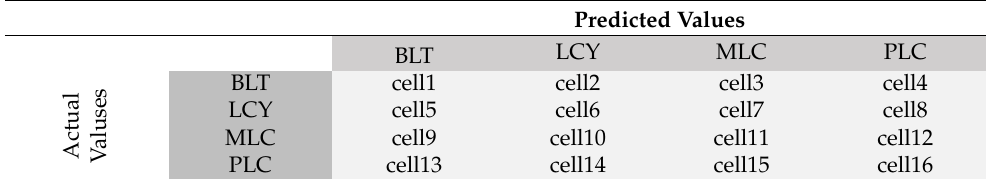
Table 1. Confusion matrix for multiclass classification. Actual values are the correct values of the ultrasound images of the test set. Prediction values are the predictions of the ultrasound images of the test set by the classifier. BLT: benign liver tumor, LCY: liver cyst, MLC: metastatic liver cancer, PLC: primary liver